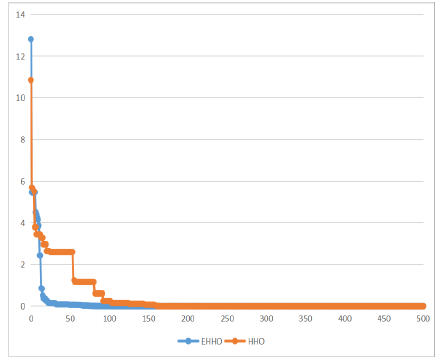
Figure 6. Ackley function.